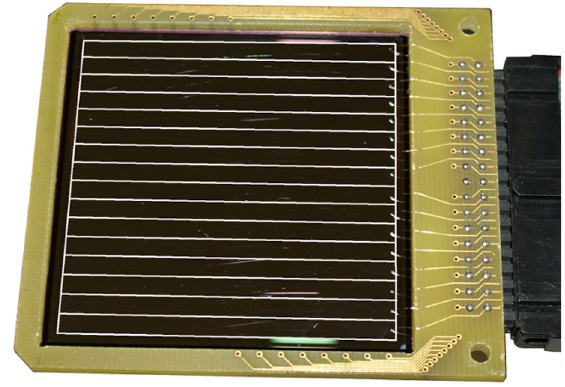
FIG. 3. W1(SS)-500 detector model from Micron Semiconductor Ltd. [8]; we can distinguish the 16 horizontal